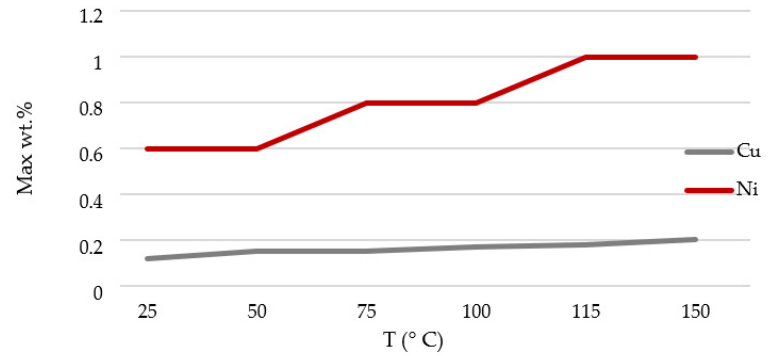
Figure 10. Maximum Cu wt.% and Ni wt.% versus operation temperature to ensure a K IC lower than 220 MPa · √ m.